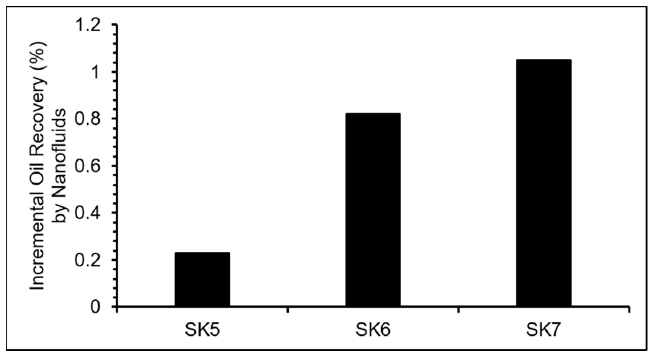
Figure 10. Tentative observation of incremental recovery from SK5-SSW, SK6-LSW and SK7-mixed.